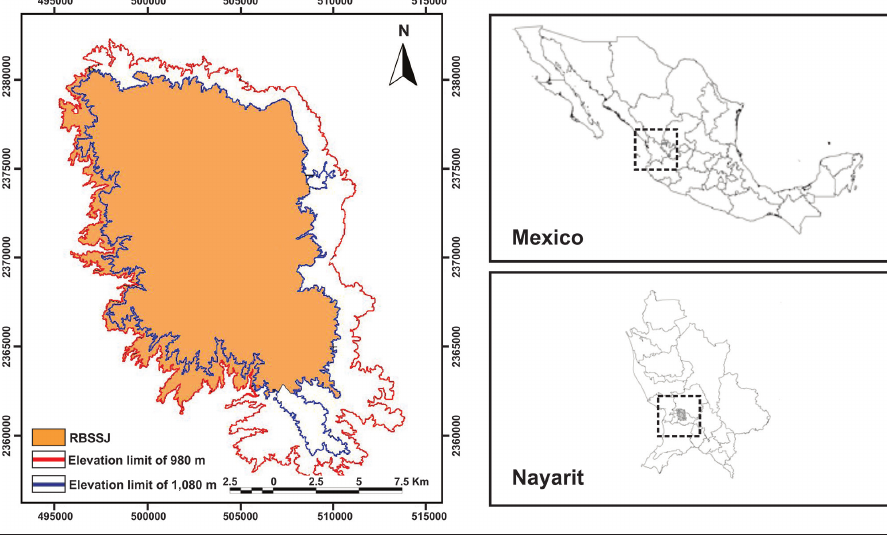
Figure 1. Location of the Reserva Estatal de la Biósfera Sierra de San Juan (REBSSJ) in the Sierra San Juan Nayarit, Mexico. Modified from González